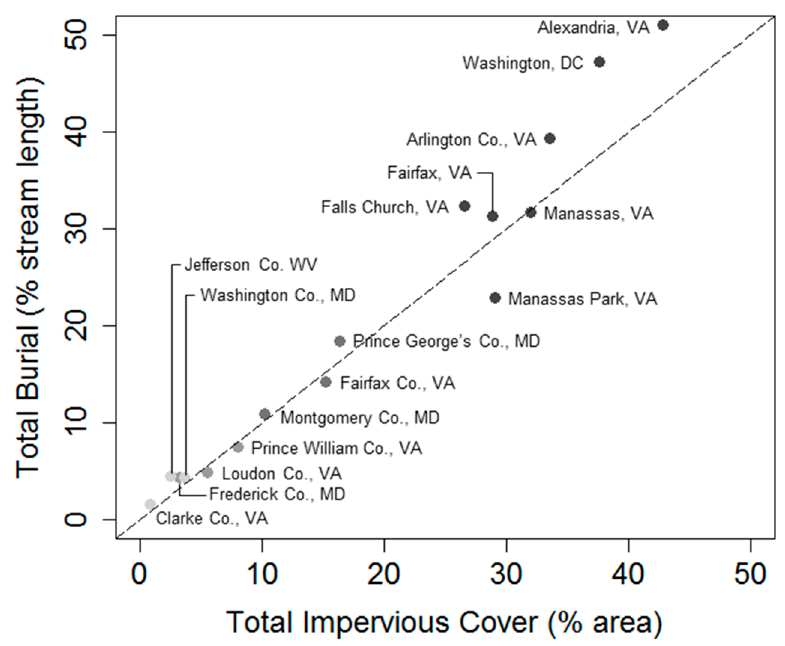
Figure 6. Percent burial as a function of impervious cover for the sixteen study counties. Colors of the points correspond with colors of development tiers in Figure 2. The dashed line represents the 1:1 line for burial and impervious cover.